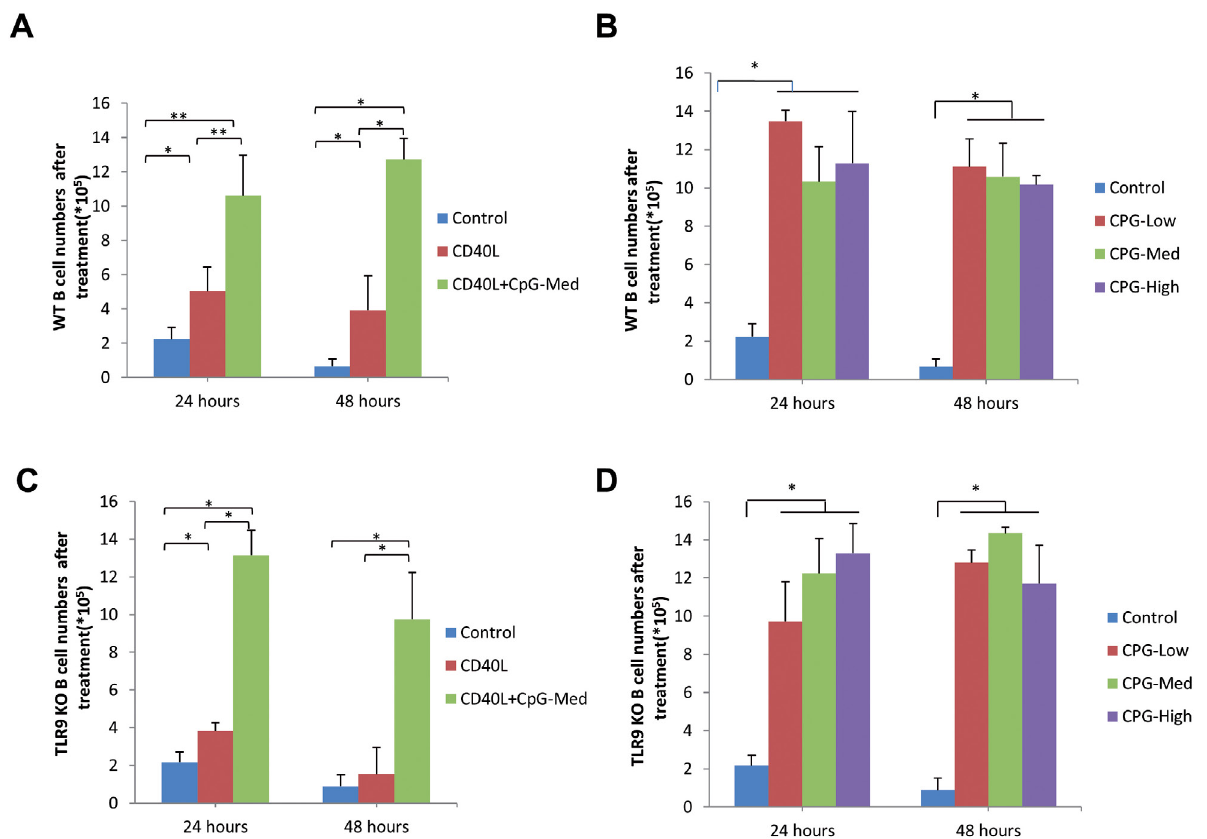
Figure 2- CpG induced proliferation of spleen B cells from WT and TLR9 KO mice. Purified spleen B cells separated from C57/BL6J (WT) mice were cultured 24 h and 48 h with (A) CD40L (0.1 μg/ml), CpG (1 μM)+CD40L (0.1 μg/ml), (B) CpG-Low (0.1 μM), CpG-Med (1 μM) and CpG-High (10 μM) (mean±SD, n=4 WT mice per group, *p<0.05, **p<0.01). Purified spleen B cells separated from TLR9 KO mice were cultured 24h and 48h with same treatment group including CD40L, CpG+CD40L(C) and different doses of CpG (D) (mean±SD, n=4 TLR9 KO mice per group, *p<0.05,